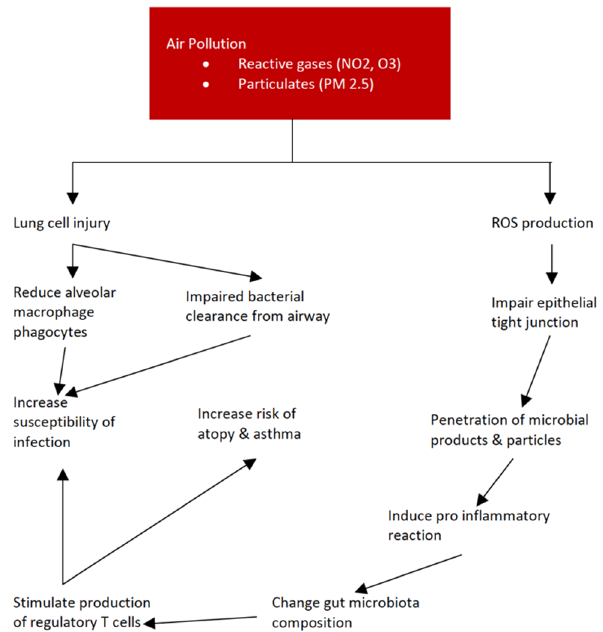
Figure 2. Pathway of the effect of air pollution on immune response (Note: ROS = reactive oxygen species).